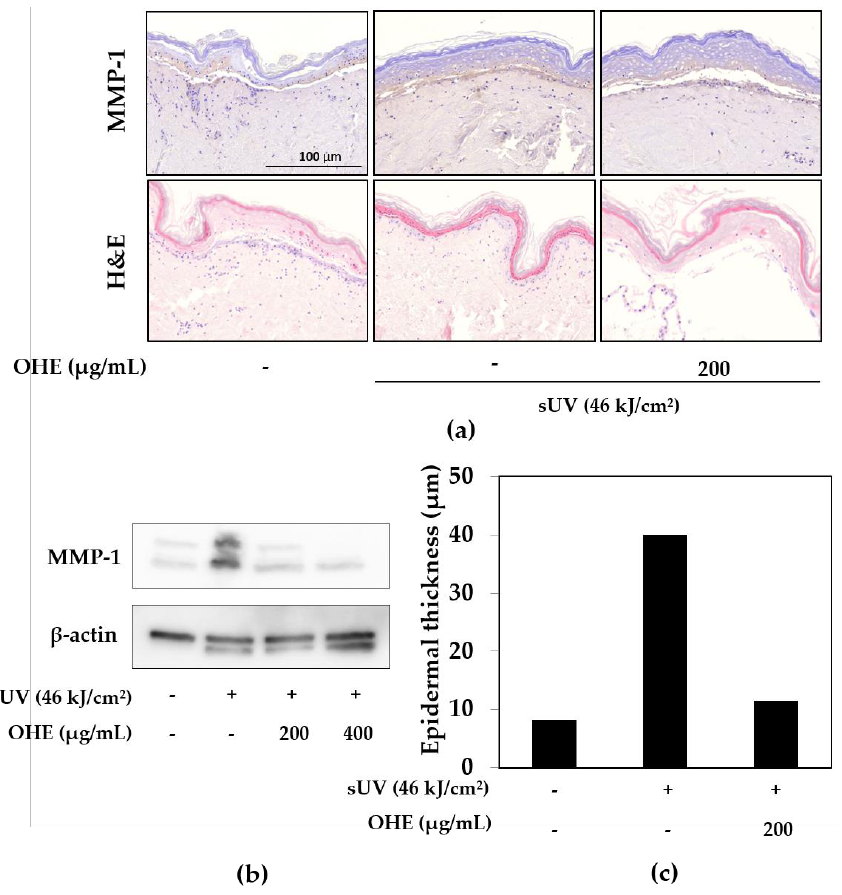
Figure 4. The effect of Opuntia humifusa fruit water extract (OHE) on solar ultraviolet (sUV)-radiated ex vivo human skin. ( a ) Histopathological analysis of matrix metalloproteinase-1 (MMP-1) and hematoxylin and eosin (H&E)-stained sections in human skin. ( b ) MMP-1 protein levels in human skin. MMP-1 expression was measured using western blot analysis, as described in Materials and Methods. ( c ) Qualitative data of epidermal thickness of human skin.